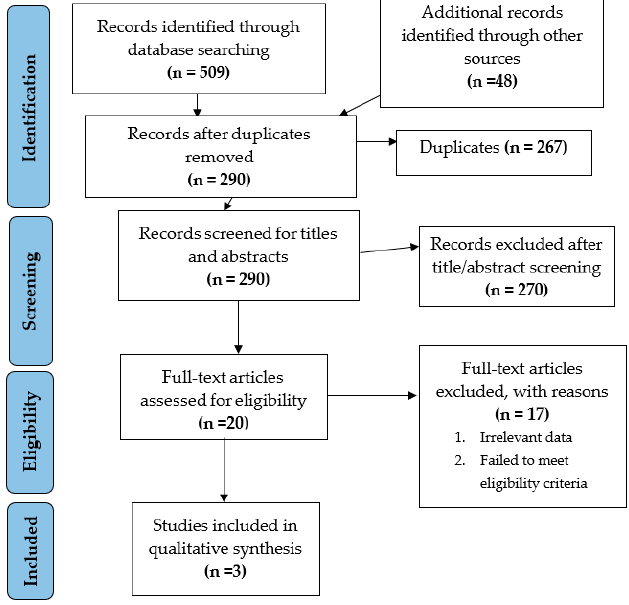
Figure 1. Flowchart summarizing the article selection process ( n— number of studies).